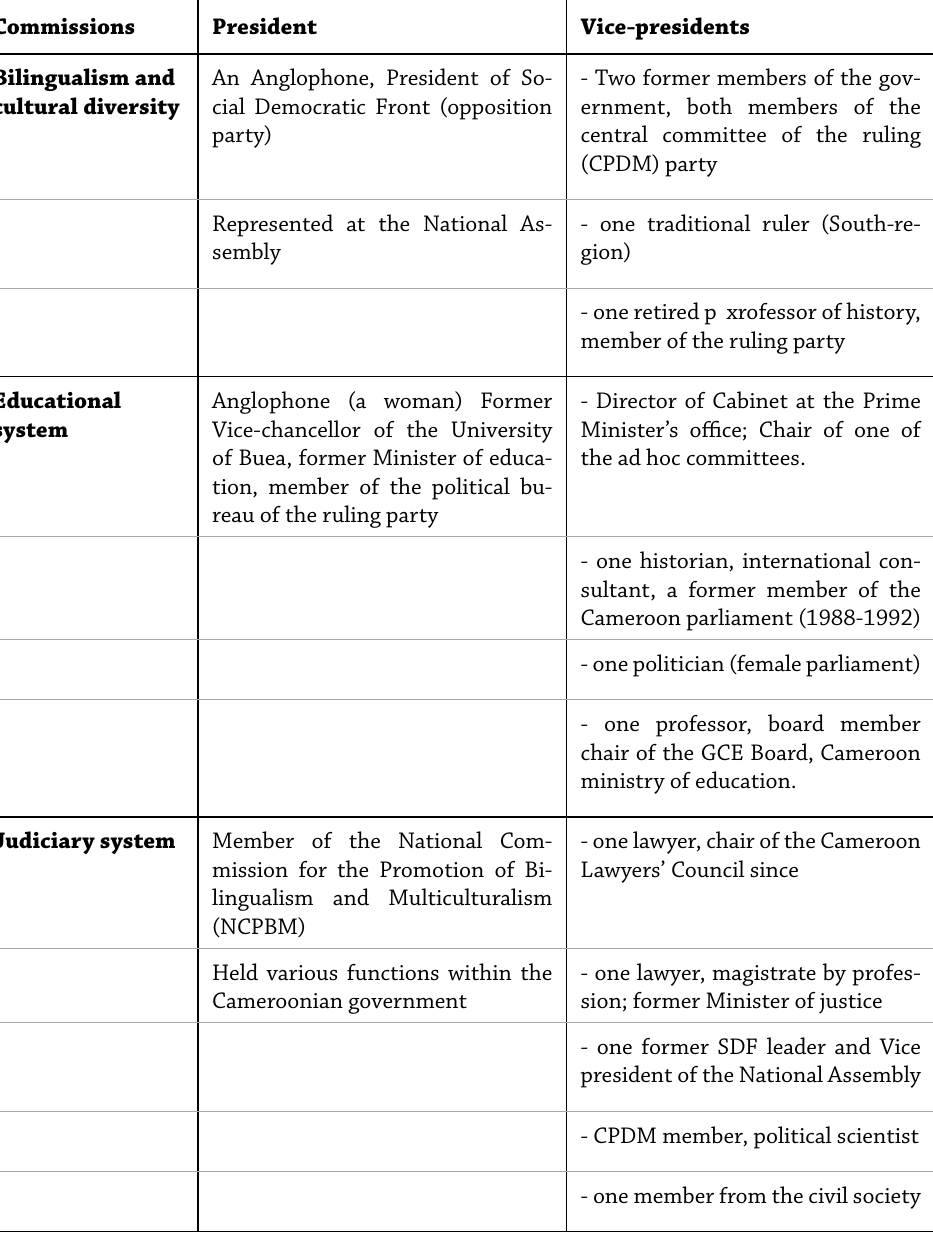
Table 1: Leading micro socio-cultural political structures in the ‘major national dialogue’